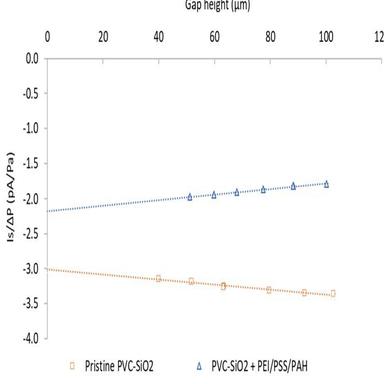
Streaming current coefficient (Is/ΔP) of the unmodified and PEI/PSS/PAH modified PVC-SiO2 membranes versus gap height; Solution: 0.001 M KCl at pH 5.60 ± 0.05.